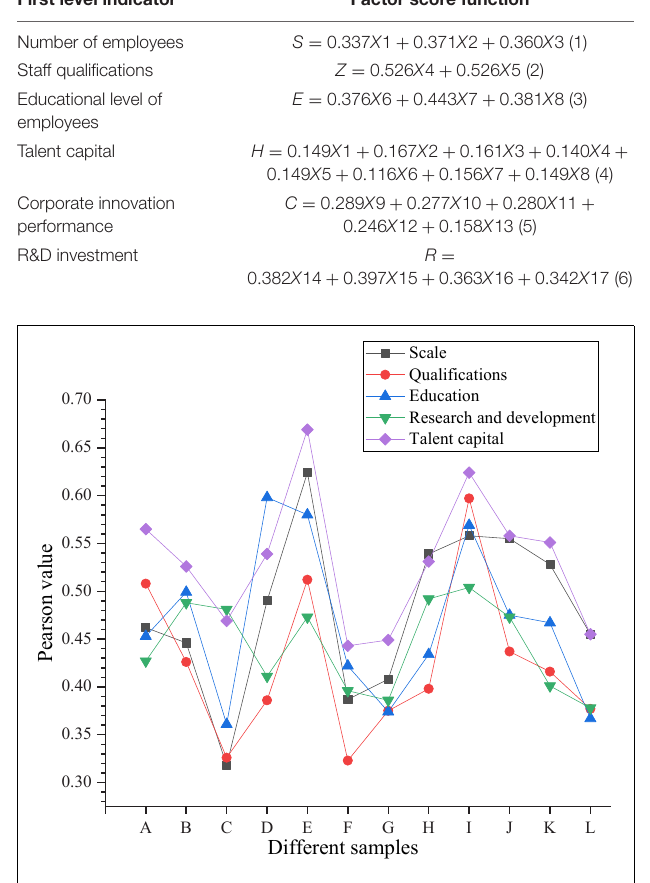
FIGURE 7 | Correlation analysis of Pearson coefficient (innovation performance).